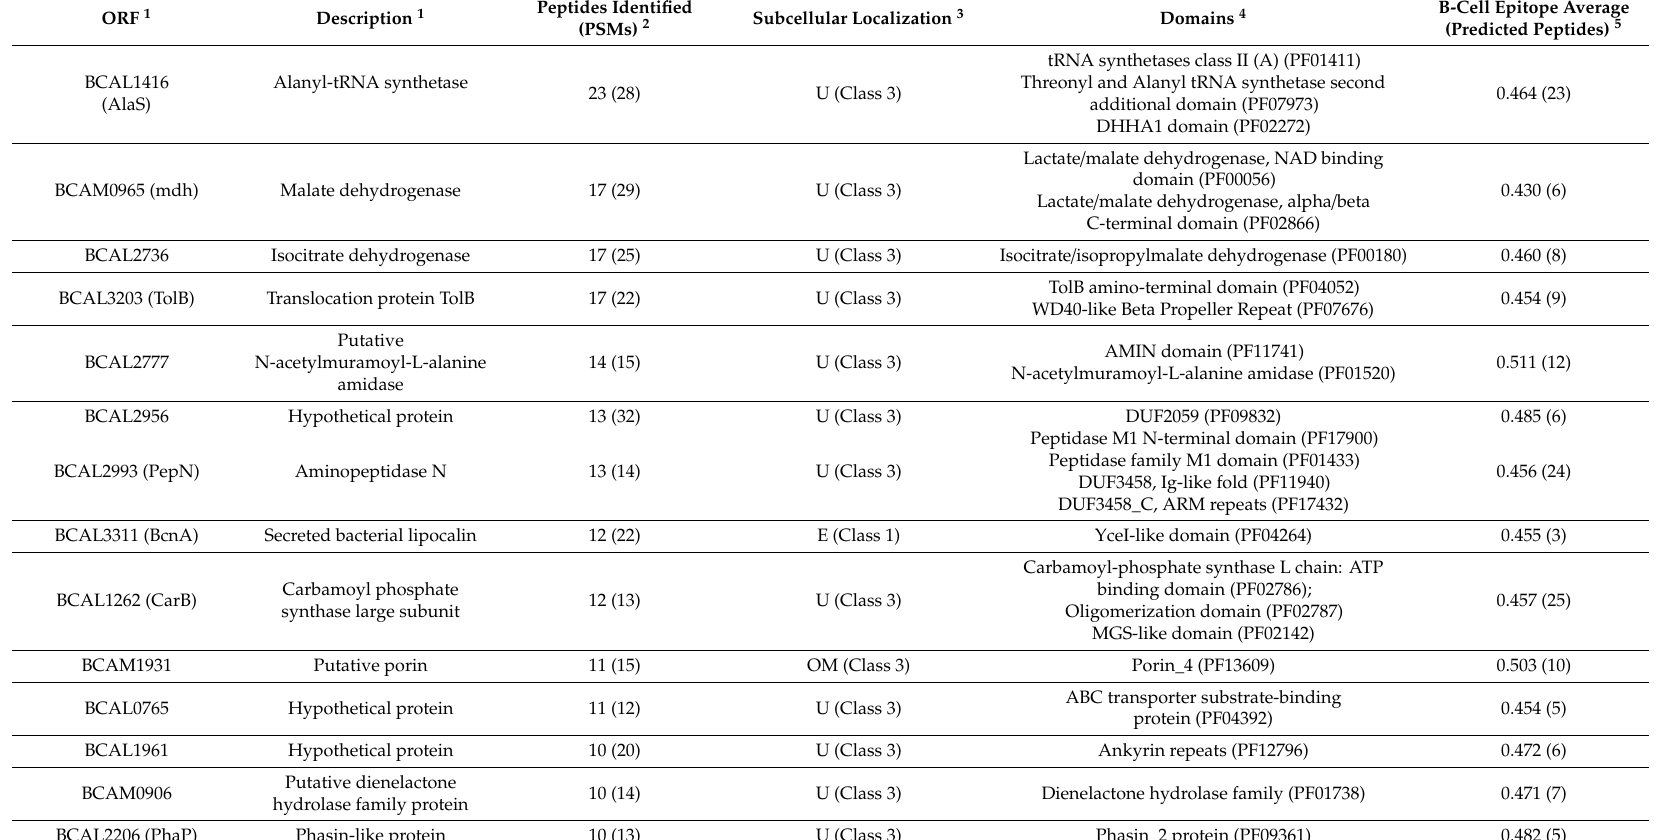
Table 2. Summary of surface-associated proteins identified in B. cenocepacia J2315 by using the “surface shaving” strategy followed by LC-MS / MS (threshold score: ≥ 5 peptides). Their subcellular localization, associated biological functions, numbers of unique peptides identified and probabilities of containing predicted immunogenic epitopes are